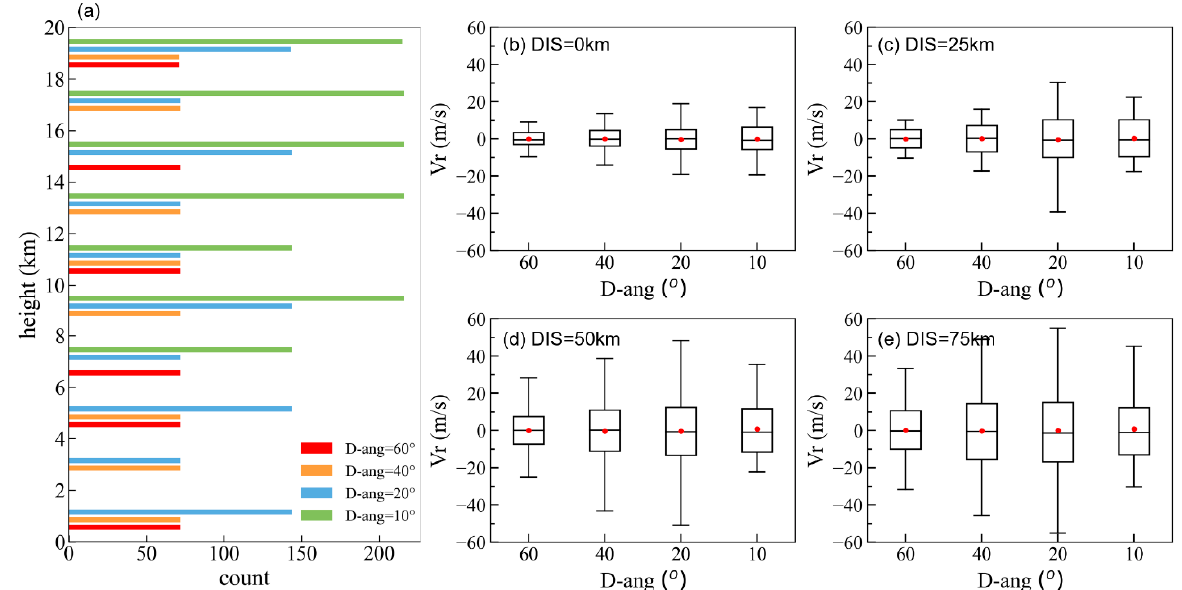
Figure 8. ( a ) The number of the simulated Doppler radar radial winds under various radar D-ang configurations. The box plot of the simulated radar radial winds when DIS equals ( b ) 0 km, ( c ) 25 km, ( d ) 50 km, ( e ) 75 km.